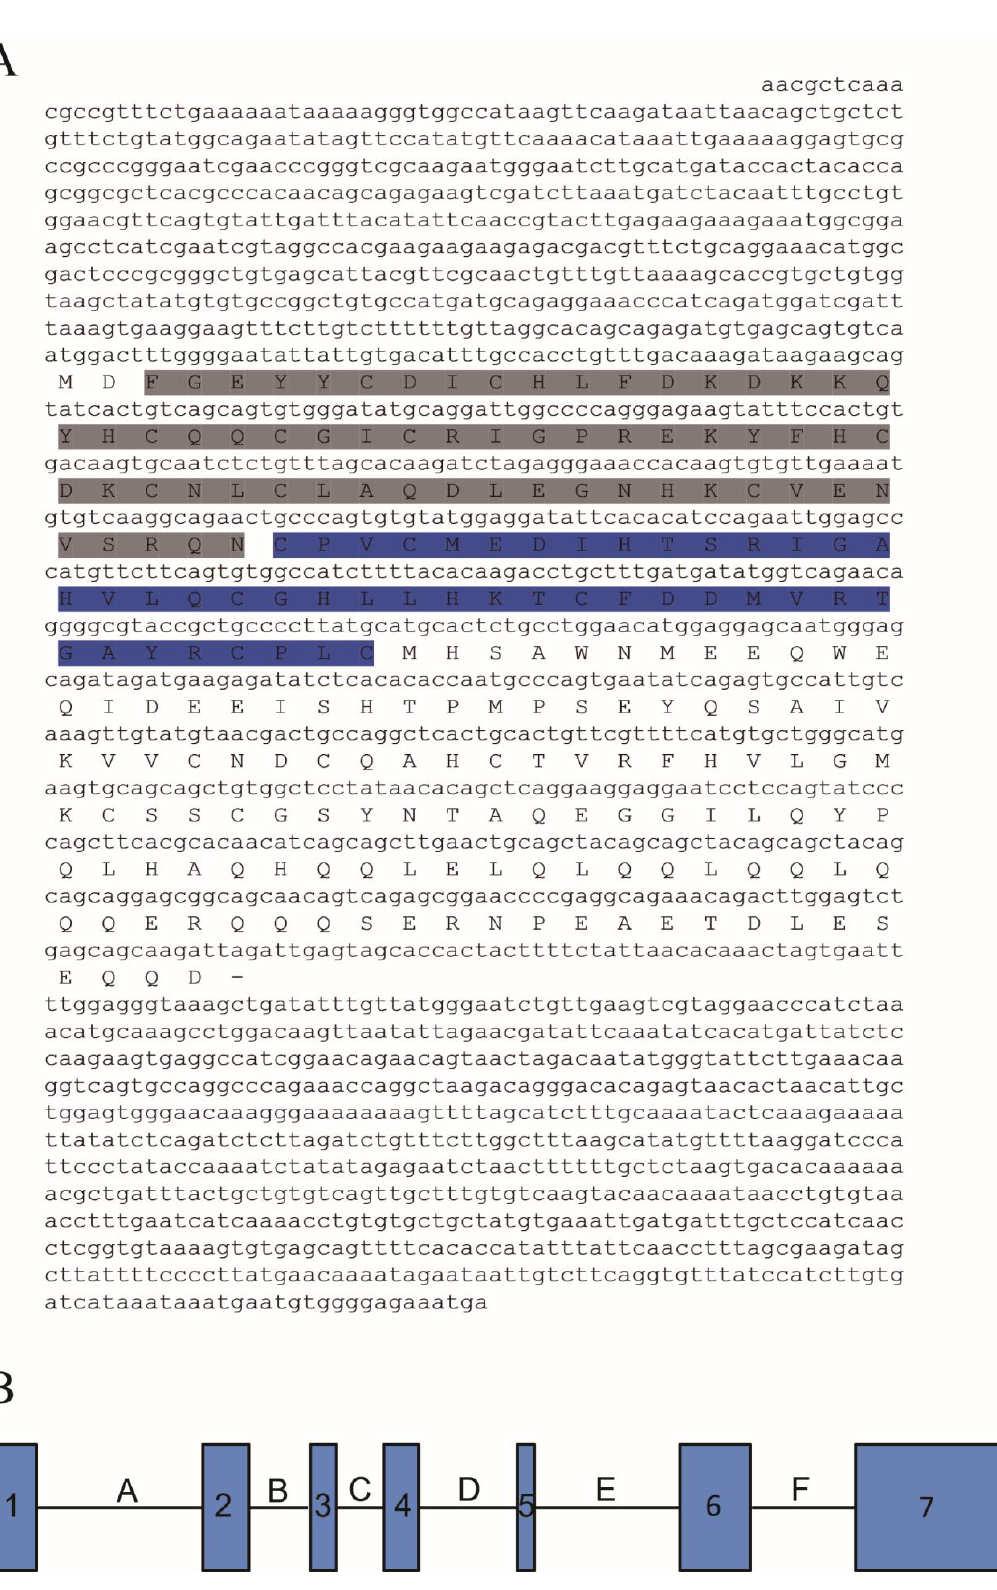
Figure 1. ( A ) The full-length cDNA and deduced amino acid sequence of Cs-rchy1 . Amino acids in grey indicated the zinc finger CTCHY-type profile and amino acids in blue indicated the zinc finger RING-type profile. ( B ) the schematic representation of Cs-rchy1 genomic structure. The exons were shown by 1–7 and only covered the CDS region (The length of exon 1 – 7: 86, 80, 45, 61, 29, 122, 252 bp). The introns were shown by uppercase A – F (The length of introns A – F: 291, 105, 81, 168, 254, 180 bp).